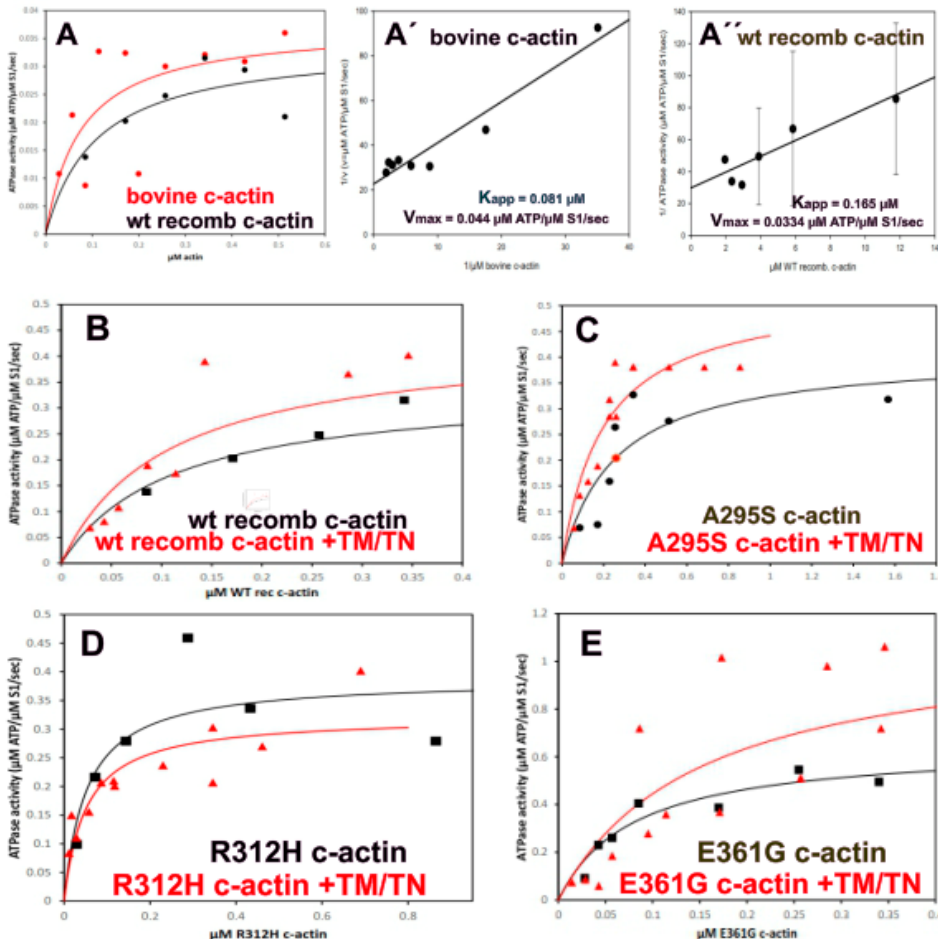
Figure 5. ( A ) Gives the dependence of the myosin-S1 ATPase stimulaztion on the concentration of bovine and recombinant wt c-actin. ( A (cid:48) , A” ) give examples of the double reciprocal evaluation of the myosin-S1 ATPase stimulation by bovine and recombinant wt c-actin, respectively. The intercept of the linear slopes with Y-axis gives 1/V max and the X-axis gives minus 1/K M , which like a Michaelis-Menten constant can be taken as an apparent binding constant. Since both values are not determined kinetically, they are named “apparent”. The results of an identical evaluation of the c-actin mutants are given in Table 2. ( B – E ) Stimulation of the myosin-S1 ATPase by increasing concentrations of the c-actin variants in the absence and presence of cTm/cTn. The ability of filamentous c-actin variants was determined by an enzyme-linked optical assay [30]. The c-actins were polymerized by 2 mM MgCl 2 plus 50 mM KCl. The ATPase activity was determined for 1 µ M rabbit skeletal muscle myosin-S1 prepared according to [31] in 5 mM HEPES-HCl, pH 7.4; 0.1 mM CaCl 2 , 2mM MgCl 2 , 50 mM KCl NADH phosphoenolpyruvate plus lactate dehydrogenase and pyruvate kinase. The time dependent decrease in optical density at 340 nm was determined with a Beckman DU640